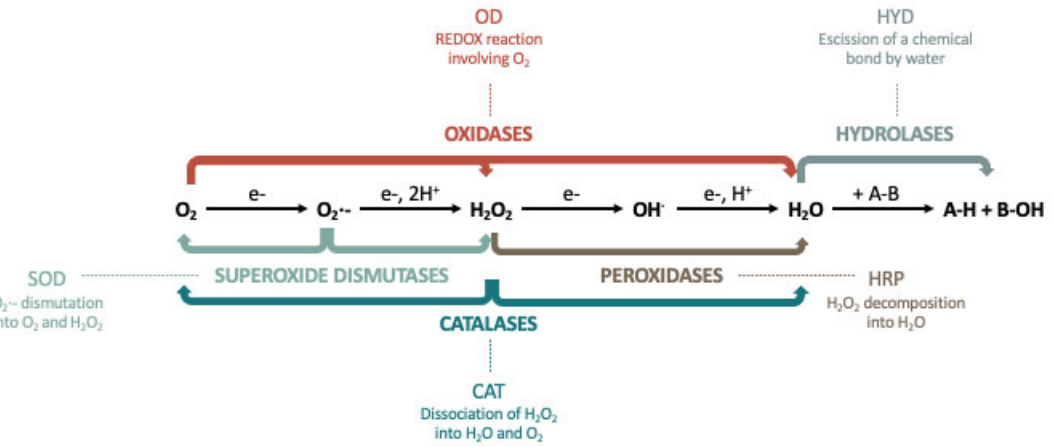
Figure 1. Scheme of the major reactions catalyzed by oxidoreductases (oxidases, superoxide dismutases, HRPs and catalases) and hydrolases. Adapted with permission from [15]. Gold ‐ based nanozymes are able to mimic a great variety of enzyme ‐ like reactions.